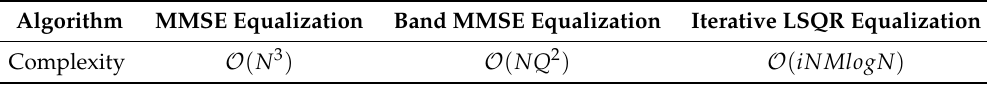
Table 1. Computational Complexity of Proposed